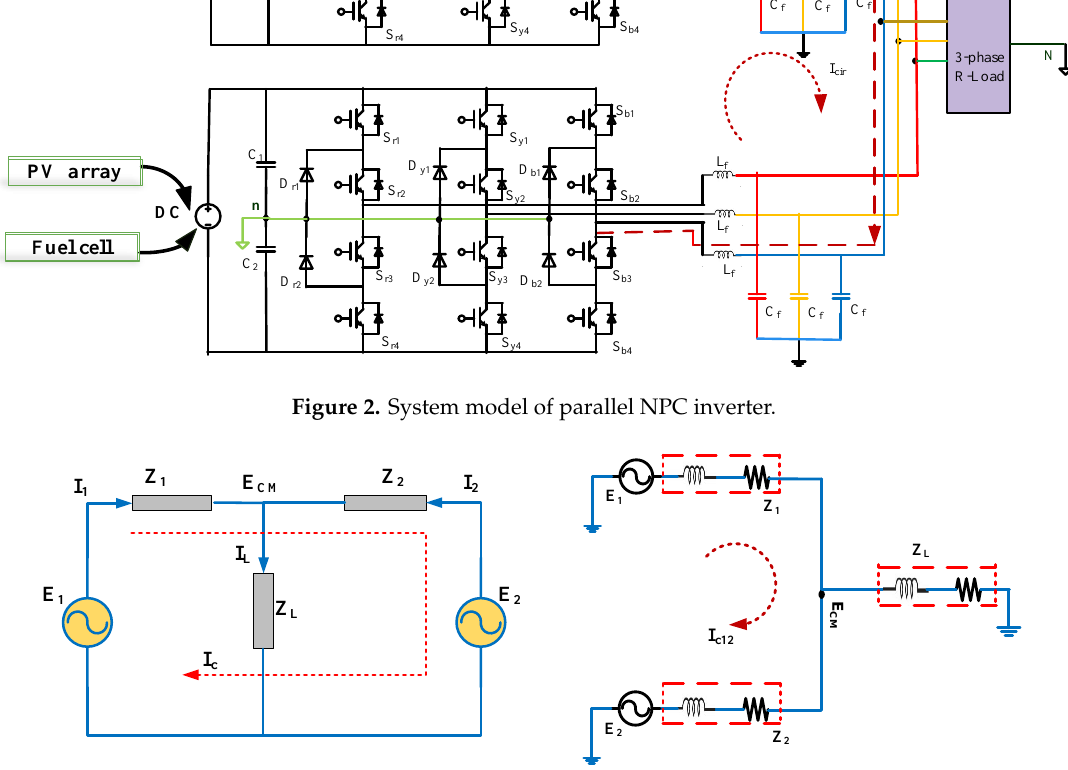
Figure 3. Equivalent model of parallel NPC inverter.